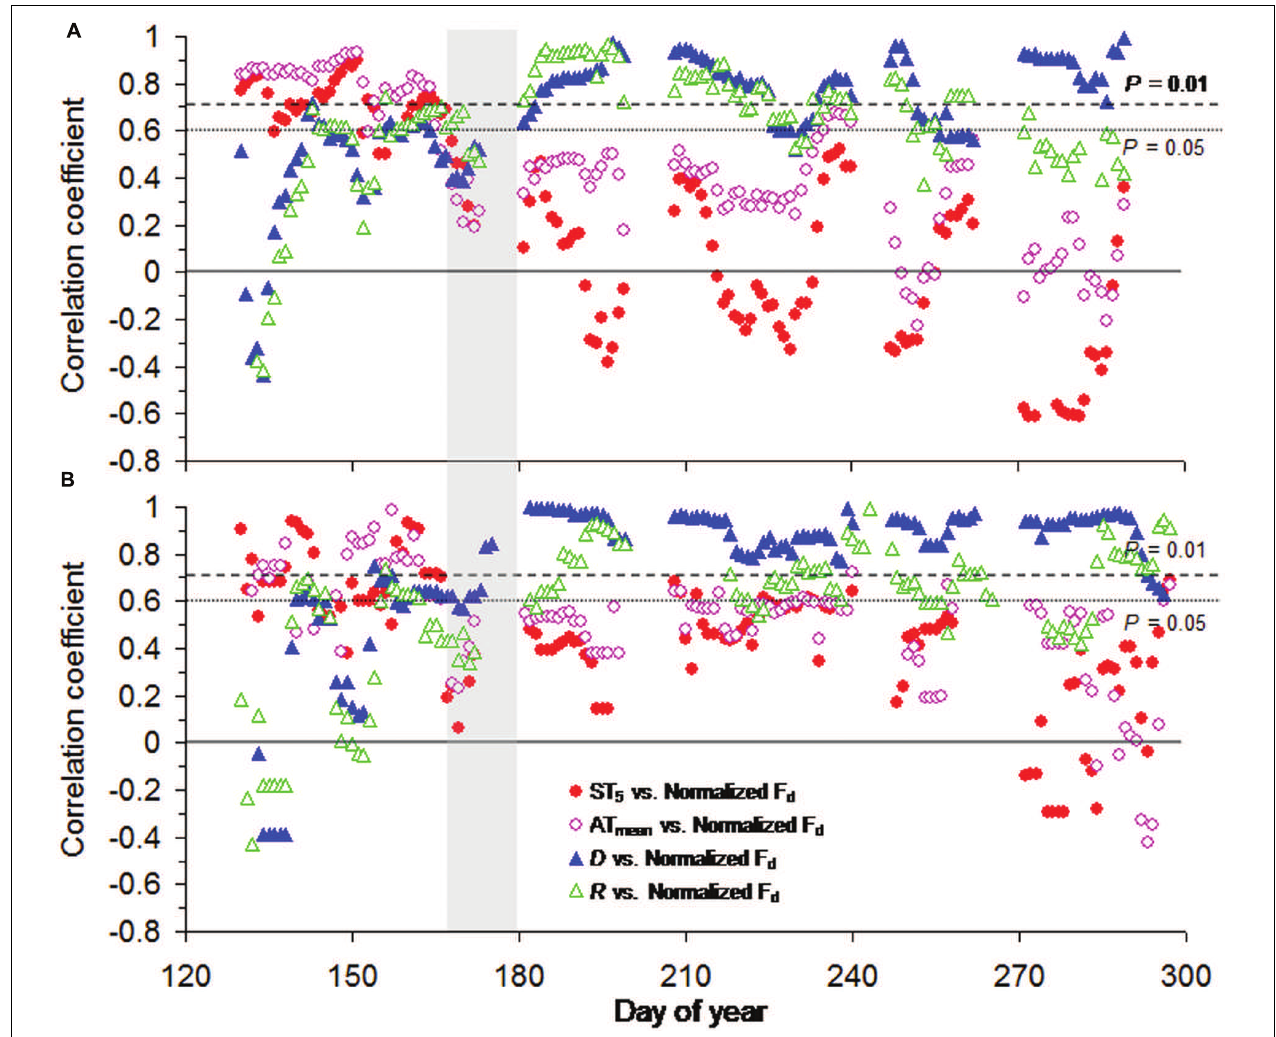
FIGURE 4 | Moving correlation analysis (10 days window) between normalized daily sum sap flow density (normalized F d ) and meteorological factors for (A) Smith fir and (B) juniper trees. The vertical gray areas indicate the period around summer solstice.